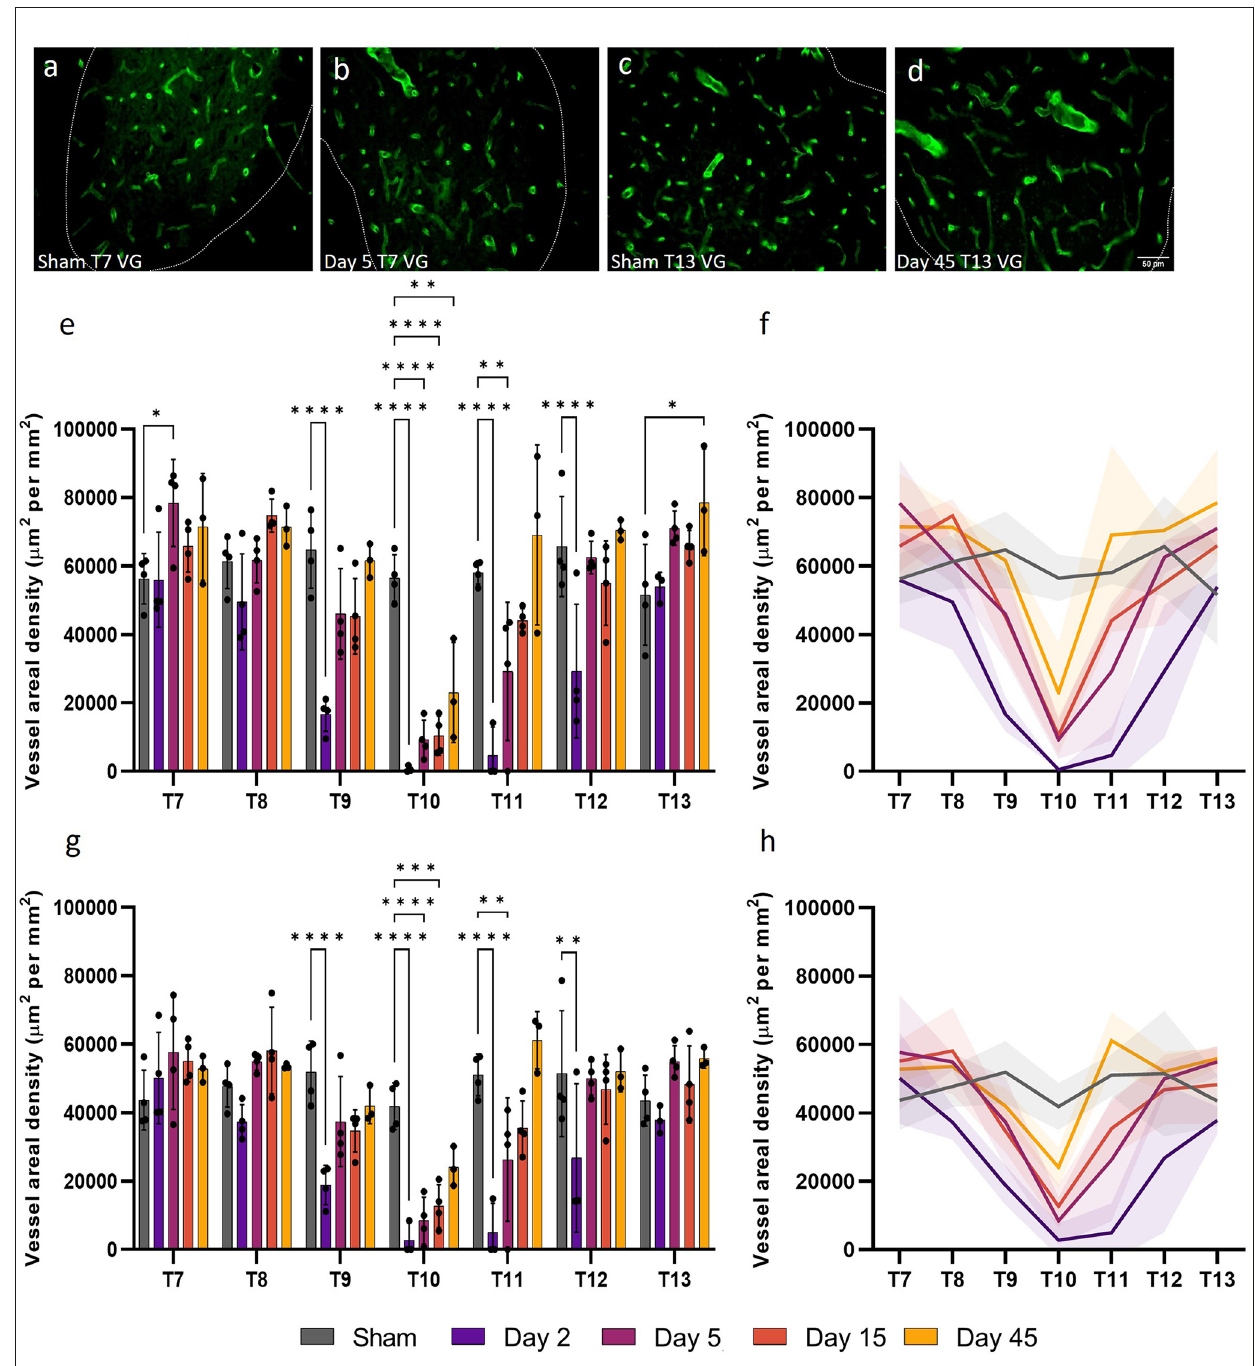
FIGURE3 Vessel areal density was significantly compromised after spinal cord injury. At day 5, microvessel areal density increased ( P < 0.05) (B) compared to shams (A) in the ventral grey (VG) matter of T7 [visualised by RECA-1 staining (green)]. A similar increase was observed at T13 in the ventral grey matter at day 45 ( P < 0.05) (D) compared to shams (C) . Microvessel areal density significantly reduced at day 2 at T9, T10, T11, and T12 in both the ventral (E,F) and dorsal (G,H) grey matter. Trend lines (F,H) show the pattern of changes over time across seven spinal segments. Scale bar = 50 µ m (A–D) . ∗ P < 0.05, ∗∗ P < 0.01, ∗∗∗ P < 0.001, ∗∗∗∗ P < 0.0001. Error bars ± SD. n = 3/4 for all